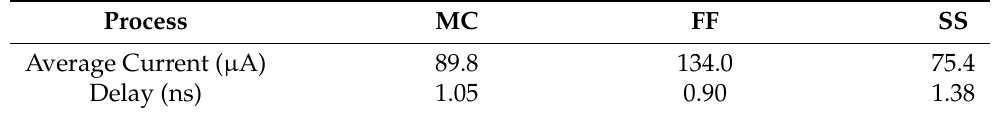
Table 5. Average current of the two-row multiplier under different